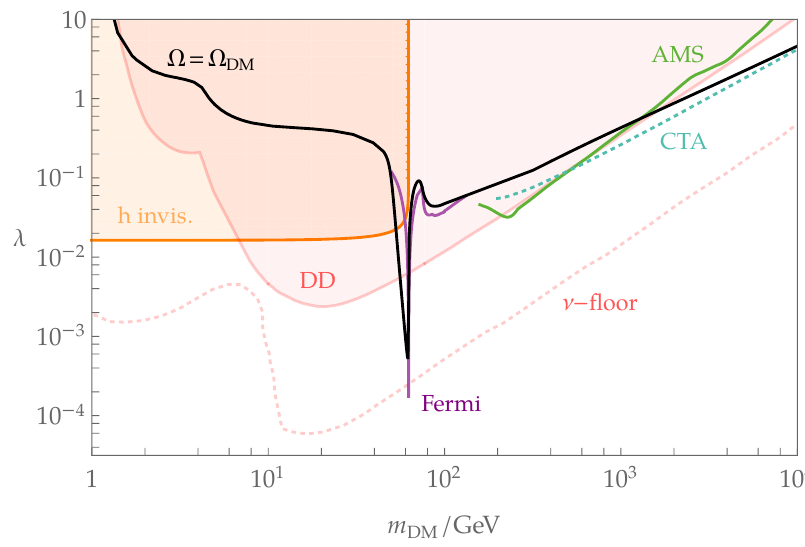
Figure 1 . The constraints on scalar Higgs portal DM models assuming a thermal cosmological history. Requiring that the relic abundance matches the measured value (cid:12)xes the value of portal coupling as a function of the DM mass to the contour labeled (cid:10) = (cid:10) DM . Direct detection experi- ments (DD) lead to strong constraints, and LHC searches for invisible Higgs decays are also relevant (h invis.). Indirect detection searches by Fermi and AMS are potentially constraining, although the latter is highly sensitive to astrophysical uncertainties (these are plotted only in parts of parameter space in which they are competitive with direct detection searches). The reach of the future CTA experiment is shown, and this could probe the high DM mass region. The neutrino (cid:13)oor ( (cid:23) -(cid:13)oor), below which direct detection searches become extremely challenging, is also